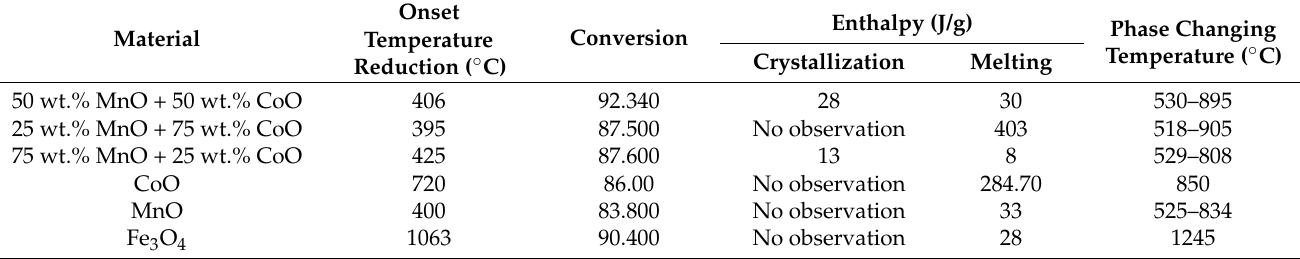
However, the standard enthalpy values for iron(II, III) oxide, Mn(II) oxide and Co(II) are −1118.4, −248.9 and −237.9 kJ respectively. Table 2. Specific energy content in kJ/g of reduction (charging) and oxidation (discharging) steps of the six materials.